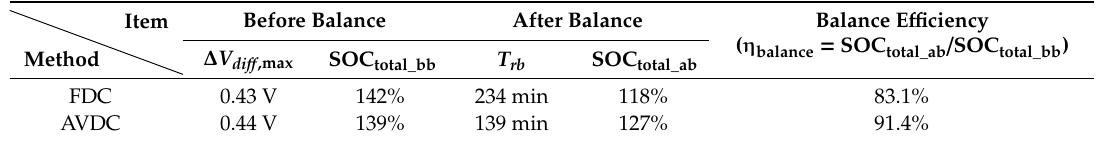
Table 6. Comparison of balance simulation